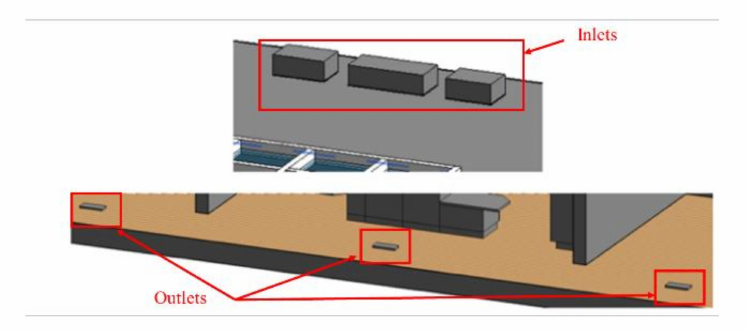
Figure 4. Inlets and outlets of the kitchen